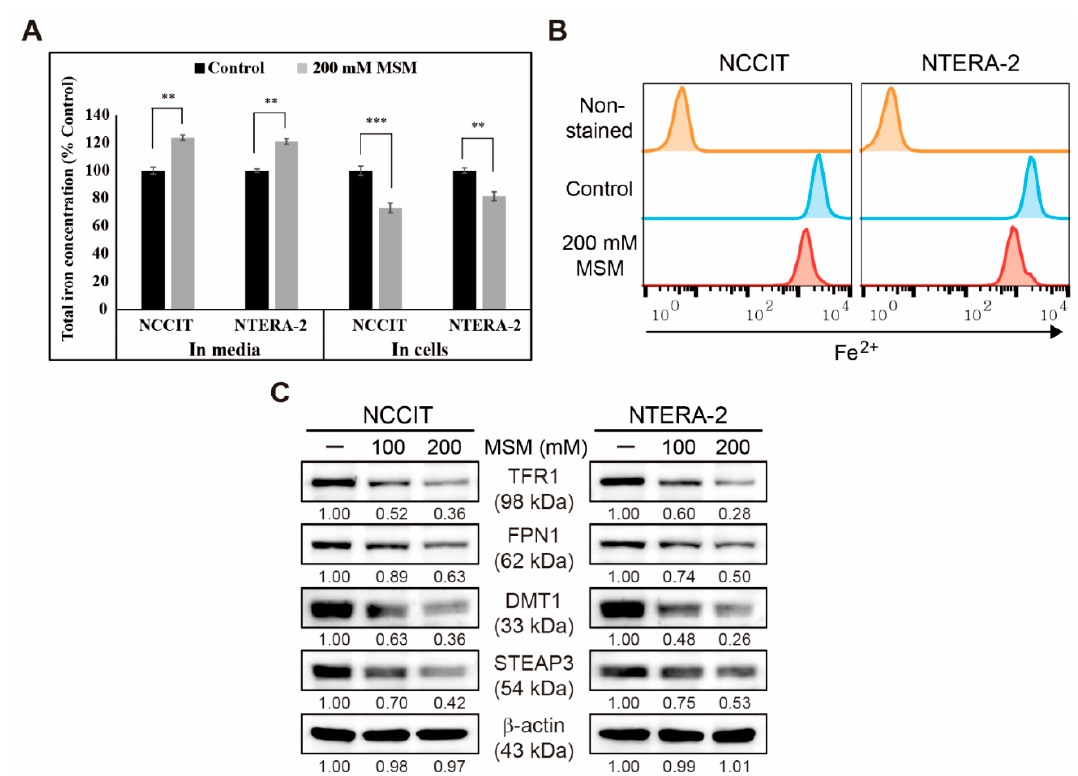
Figure 4. MSM suppressed iron metabolism. ( A ) Iron assay showing total iron concentration in NCCIT and NTERA-2 cells treated with MSM (200 mM) for 48 h. Data were obtained in triplicate. Controls were set at 100. ** p < 0.01 and *** p < 0.001 (Student’s t -test). ( B ) Flow cytometry showing the expression of Fe 2+ in NCCIT and NTERA-2 cells after treatment with MSM (200 mM) for 48 h. The graphical representation shows cells with intracellular Fe 2+ level. ( C ) Western blotting of TFR1, FPN1, DMT1, and STEAP3 in NCCIT and NTERA-2 cells after treatment with MSM (100 and 200 mM) for 48 h. Expression levels were estimated by densitometry and normalized to β -actin. Data were obtained in